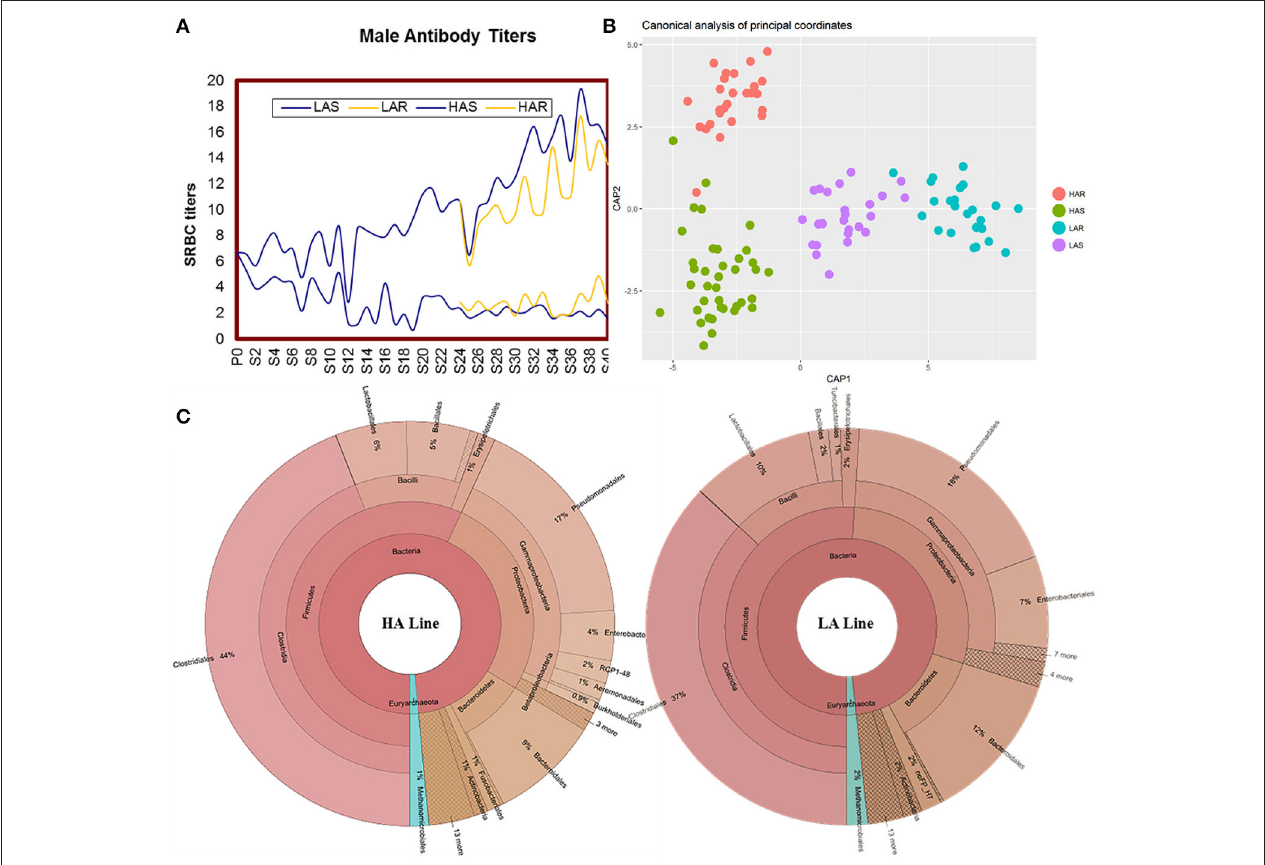
FIGURE 1 | (A) Mean sheep red blood cell (SRBC) antibody titers over 40 gene rations for male chickens. Selected lines shown in blue, with relaxed lines shown in yellow. (B) Canonical analysis of principal coordinates (CAP) analysis based on unweighted UniFrac metrics. (C) The distribution of the gut microbiota composite for HA and